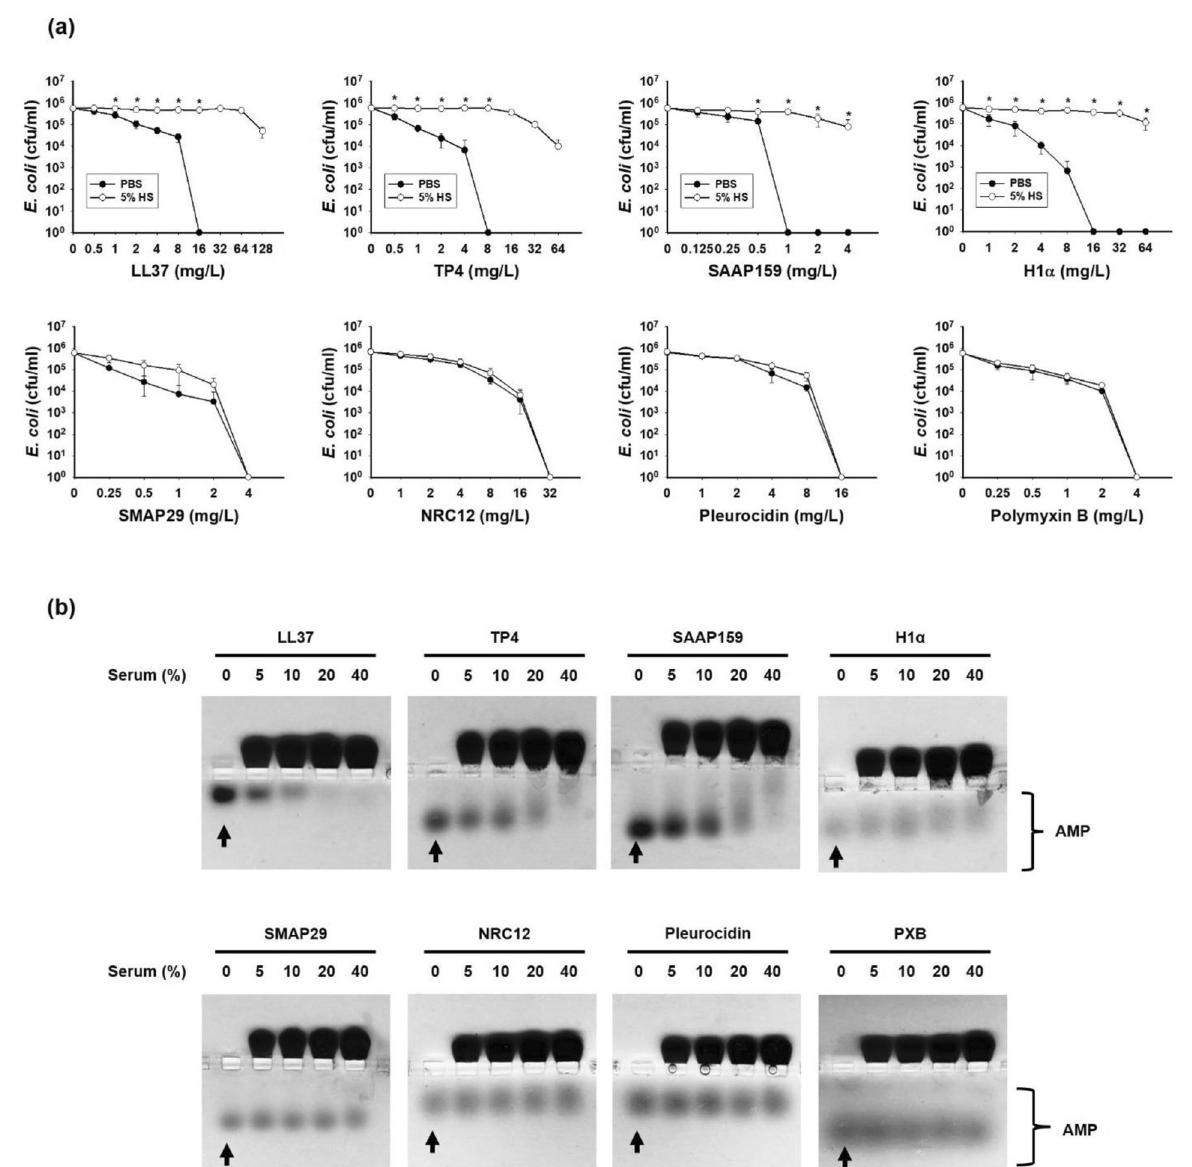
Figure 1. Susceptibility of antimicrobials to human serum inhibition. ( a ) Effect of human serum on the bactericidal activities of antimicrobials against E. coli (10 6 cfu/ml). Values are the mean ± SD (n = 3). Mann– Whitney tests were performed to determine the significance of the difference. * Indicates P ≤ 0.05 compared with PBS group. ( b ) The band shift of antimicrobials (4 µg each) in 10 µl diluted human serum analyzed by 8% horizontal native PAGE and Coomassie blue staining. Arrow indicates control (non-shift) AMP. PBS, phosphate-buffered saline; 5% HS, 5% human serum in PBS